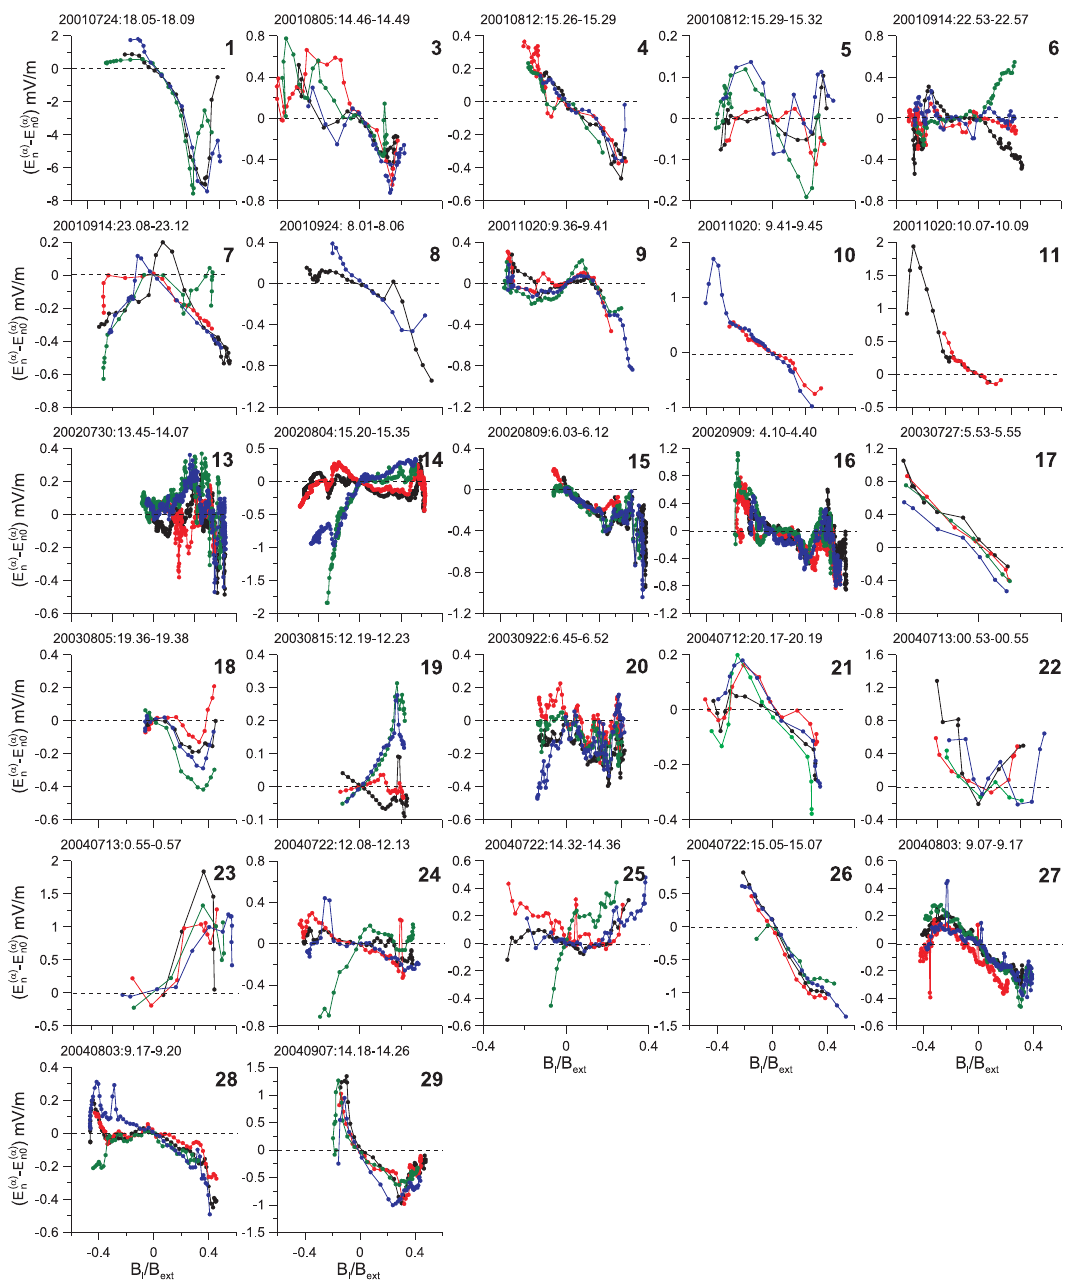
Fig. 10. Profiles of electric fields E (α) n − E (α) . Black, red, green and blue curves correspond to the measurements of C1–C4, respectively. n 0 Central ticks at horizontal axes of each panel correspond to B l = 0, while one large tick interval is equal to